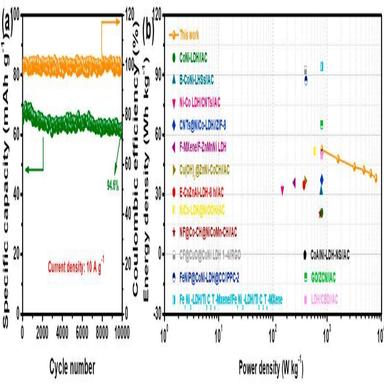
(a) Cycling performance and Coulombic efficiency of the device at the constant current density of 10 A g− 1 . (b) The Ragone plot related to energy and power densities compared to other devices.